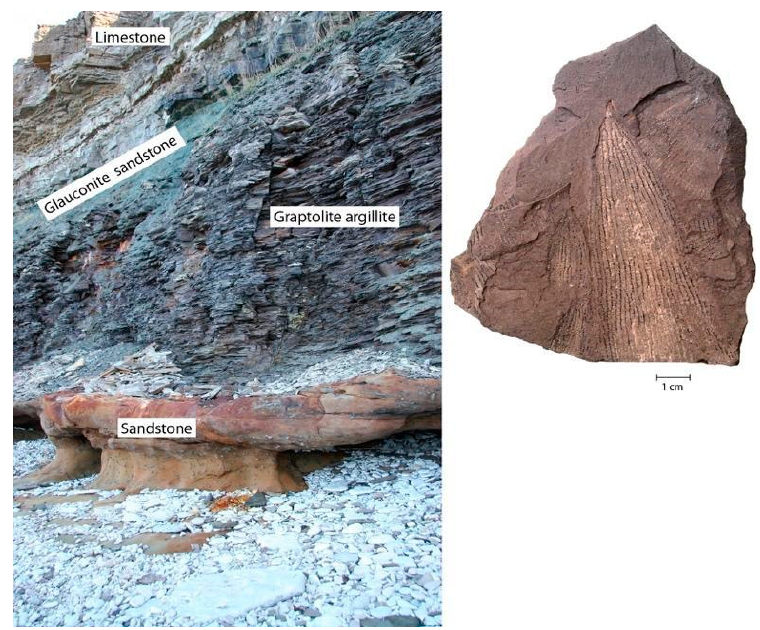
Figure 2. Cross-section of the northern Estonian klint at Cape Pakri ( left ). The thickness of the graptolite argillite is about 4.2 m, it is overlain with glauconite sandstone and limestone. Graptolite argillite shale with Rhabdinopora flabelliformis imprint ( right ).